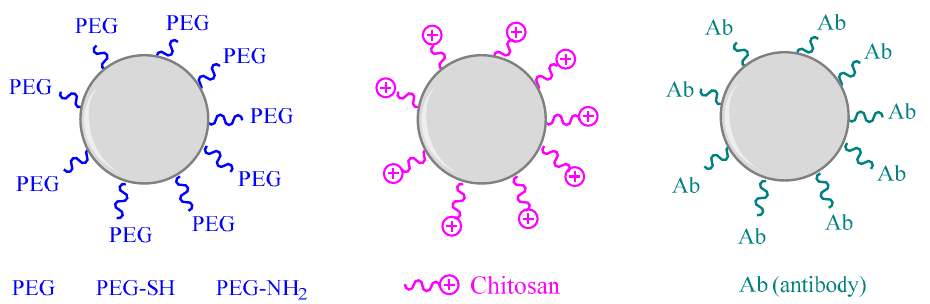
Figure 3. Surface and coating modification strategies of metal and metal oxide nanoparticles (based on [134,138,146]).